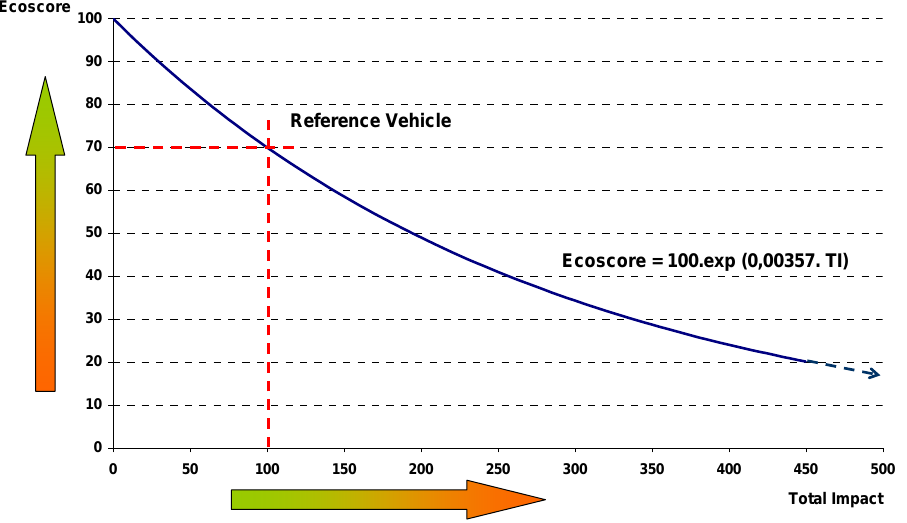
Figure 1. Transformation Total Impact to